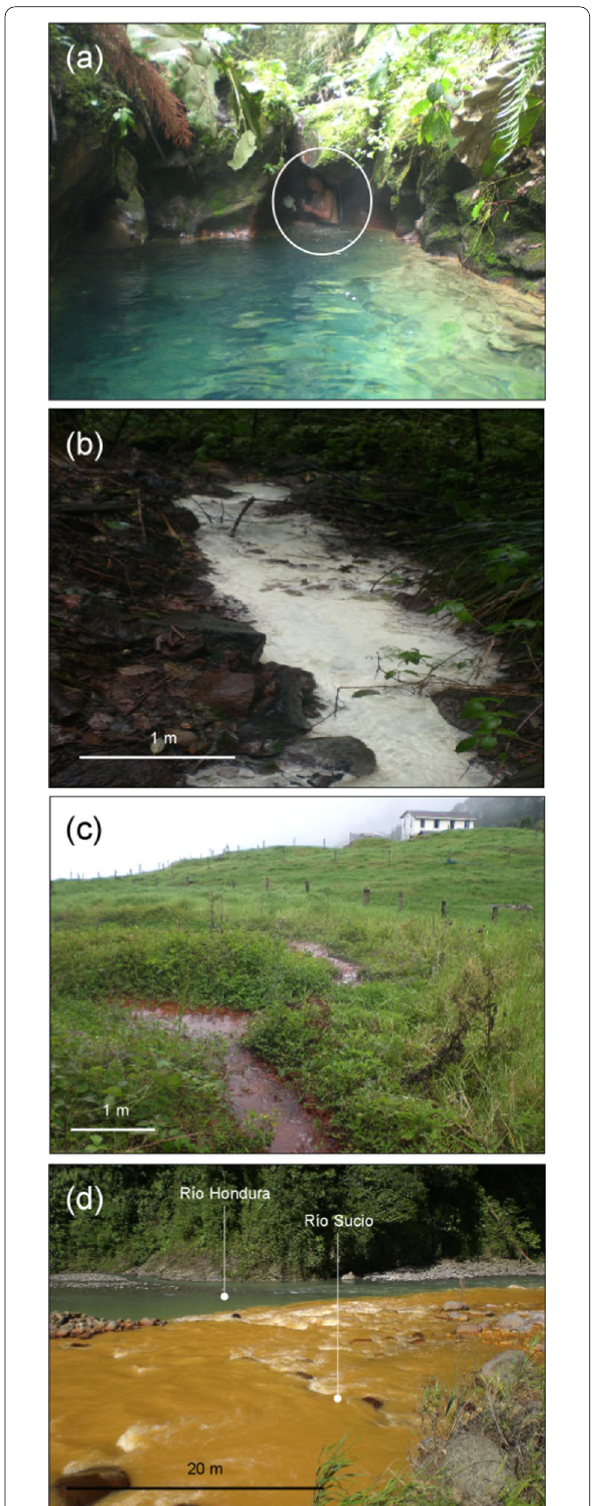
Fig. 4 a San Cayetano thermal spring discharging into a blue‑colored pool from a cave‑like structure (in April 2007). Mind the person in the circle for scale. b Ojo de Agua thermal springs discharging well‑known milky‑white waters (in December 2009). c Santa Teresita thermal springs discharging red‑brown waters into a flat meadowland near the”lechería” site (in December 2009). d View of the Río Sucio river with its peculiar brown‑orange waters converging with the clear waters of Río Hondura river ~ 18 km north of Irazú volcano (in December 2009). Pictures by D.